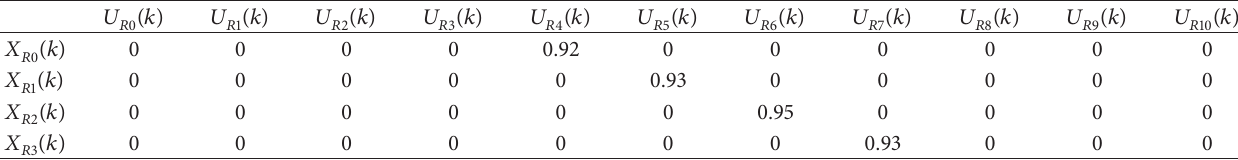
of the sensitivity of unconscious YF